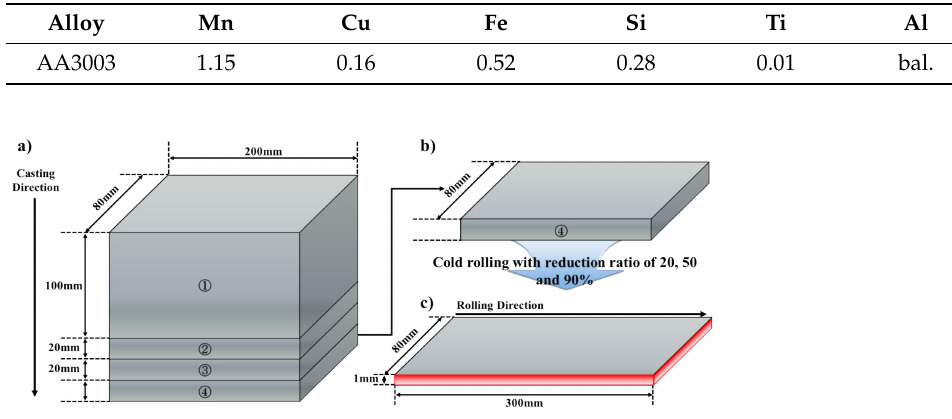
Table 1. Chemical composition of commercial AA3003 aluminum alloy used in this study (wt%).